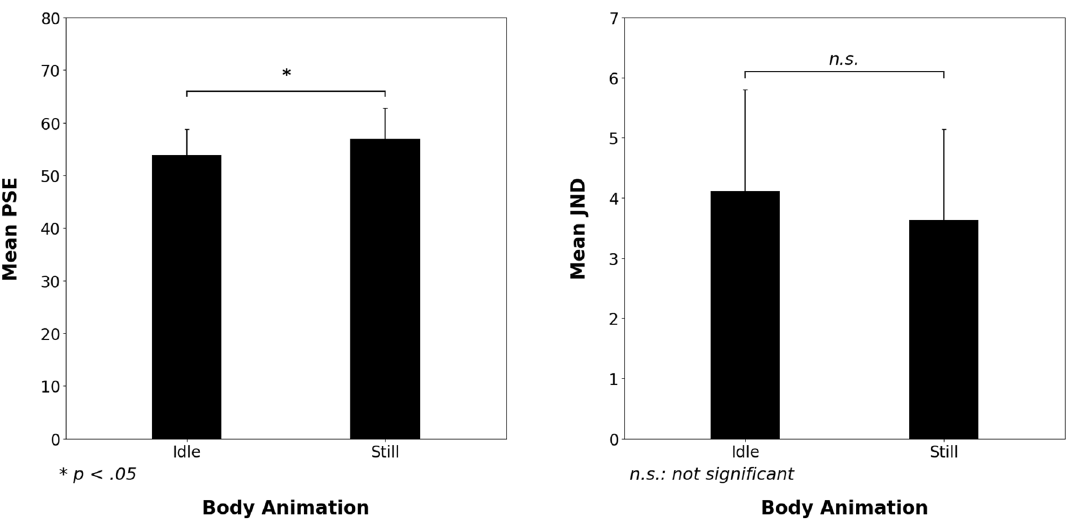
Figure 5. Mean of PSE and JND obtained from the logistic modelling of “Touched” responses of each participant in the still and idle conditions . Error bars correspond to the confidence intervals at